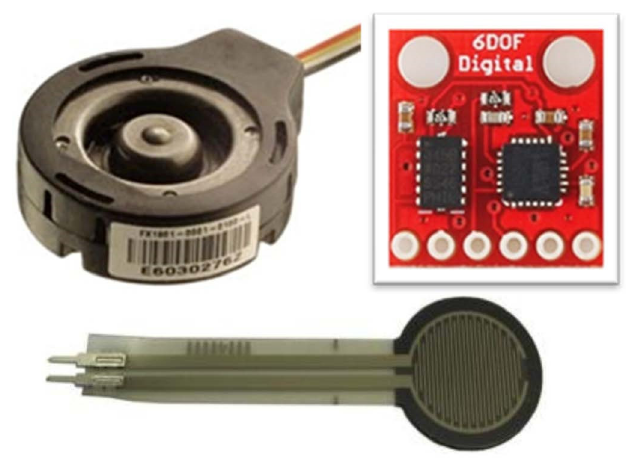
Figure 3. Force sensors, IMU sensor, and Interlink FSR sensor.